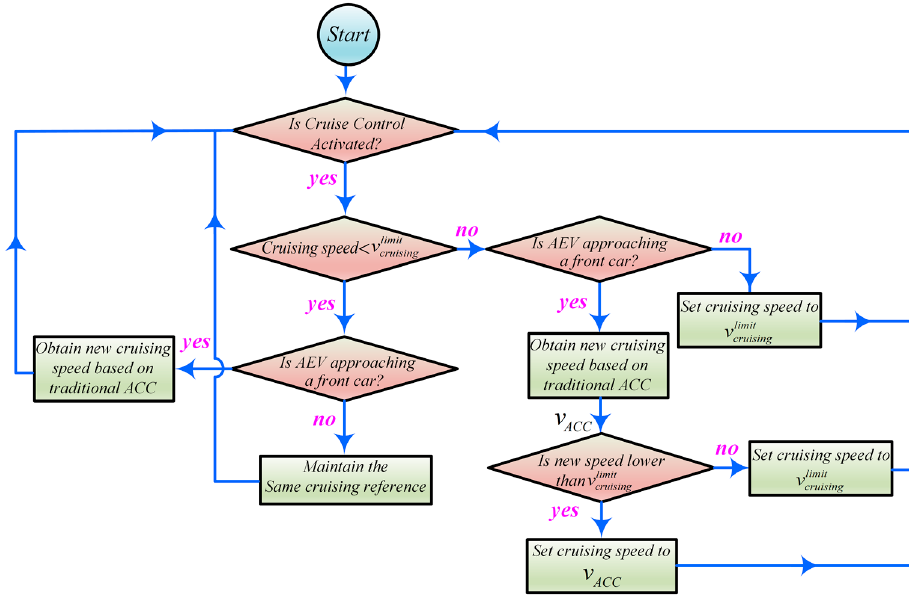
Figure 5. Flowchart of the proposed ACC system.